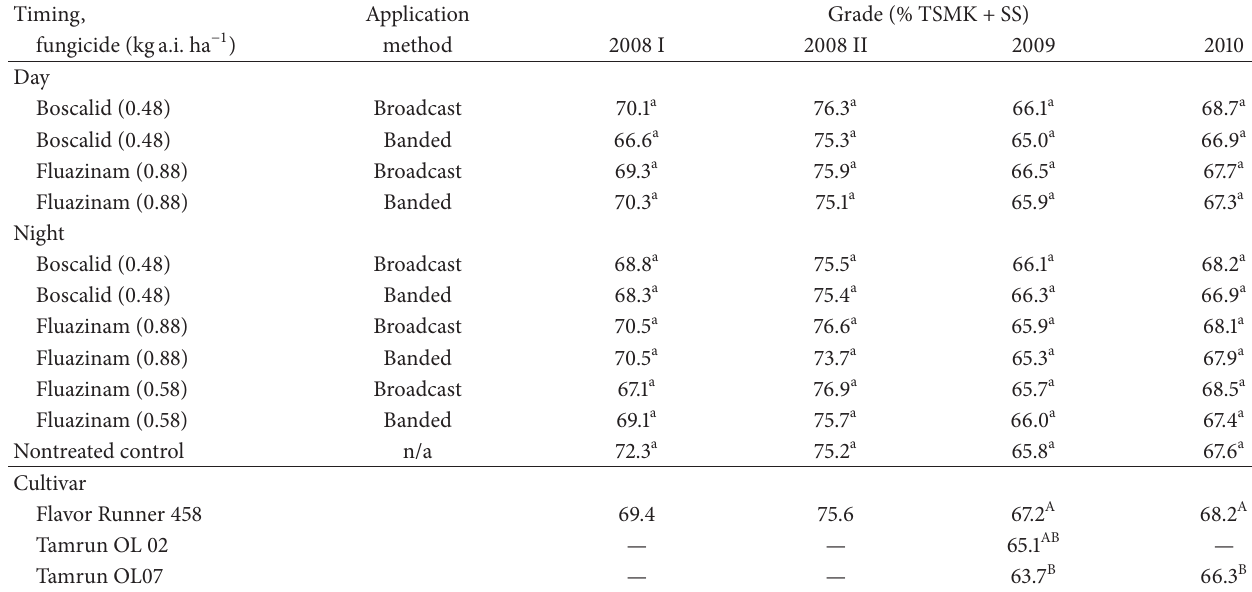
Table 5: Effect of broadcast and banded applications of the fungicides boscalid and fluazinam applied at different times of the day on peanut grade a .